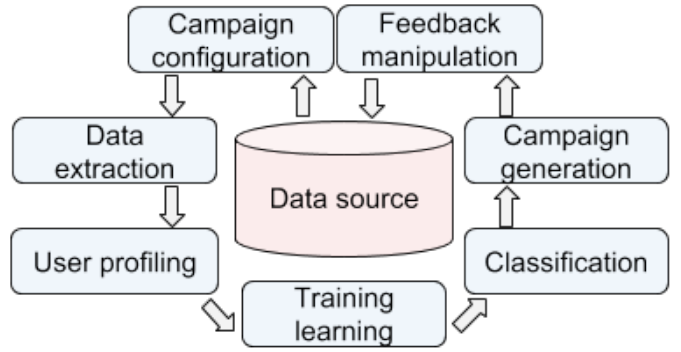
Figure 1. System structure. Campaigns are generated iteratively. All the process is automatized; The stakeholder configures the campaign, generates the model and assign the scores, and the results are included in the database for future